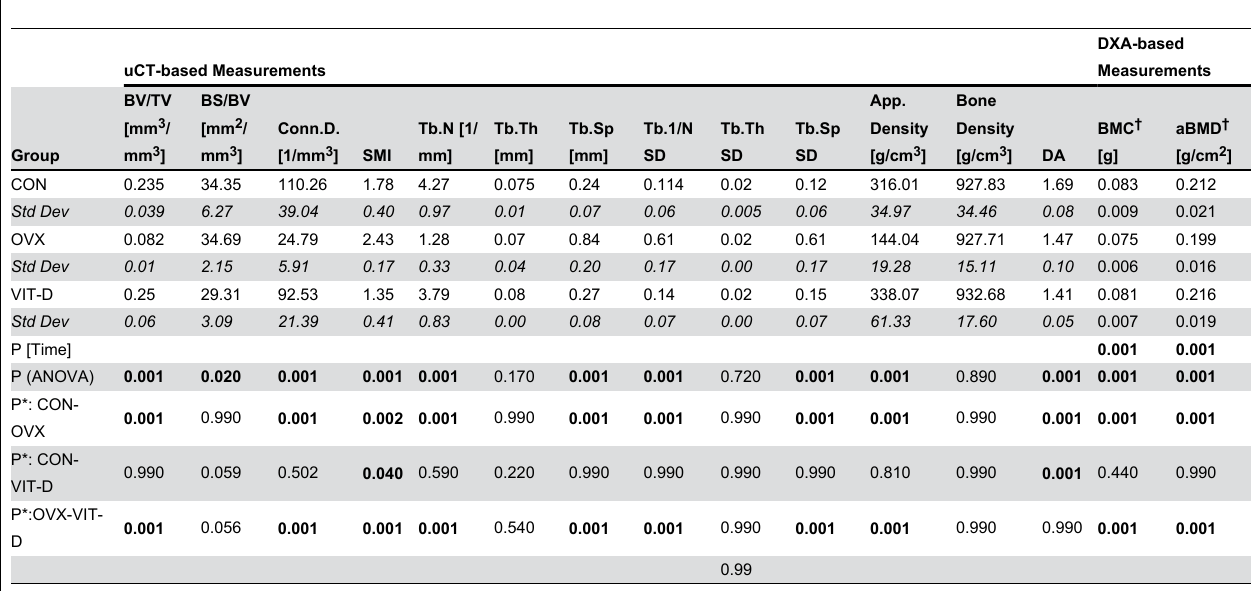
Table 3. μCT based morphometric indices and DXA based densitometric values for cancellous bone specimens.